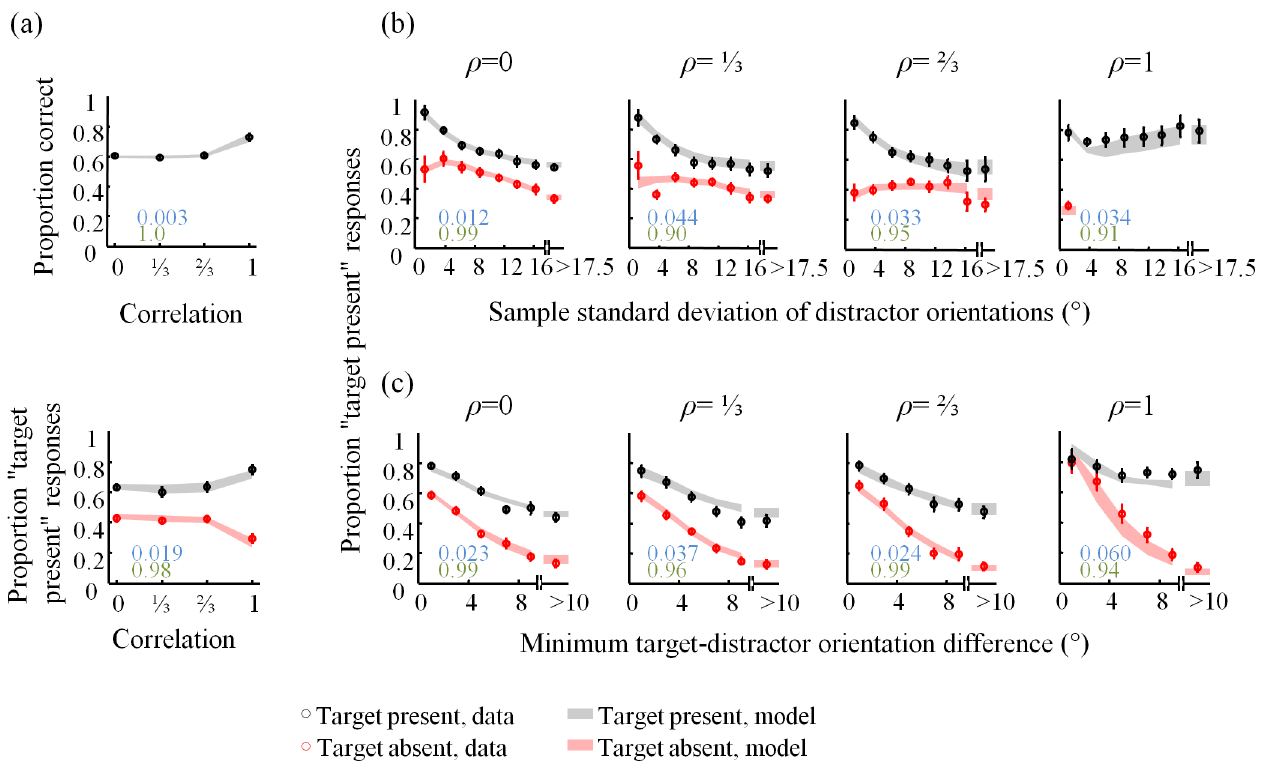
Fig 9. Fits of the VP5 model to the summary statistics. For caption, see Fig